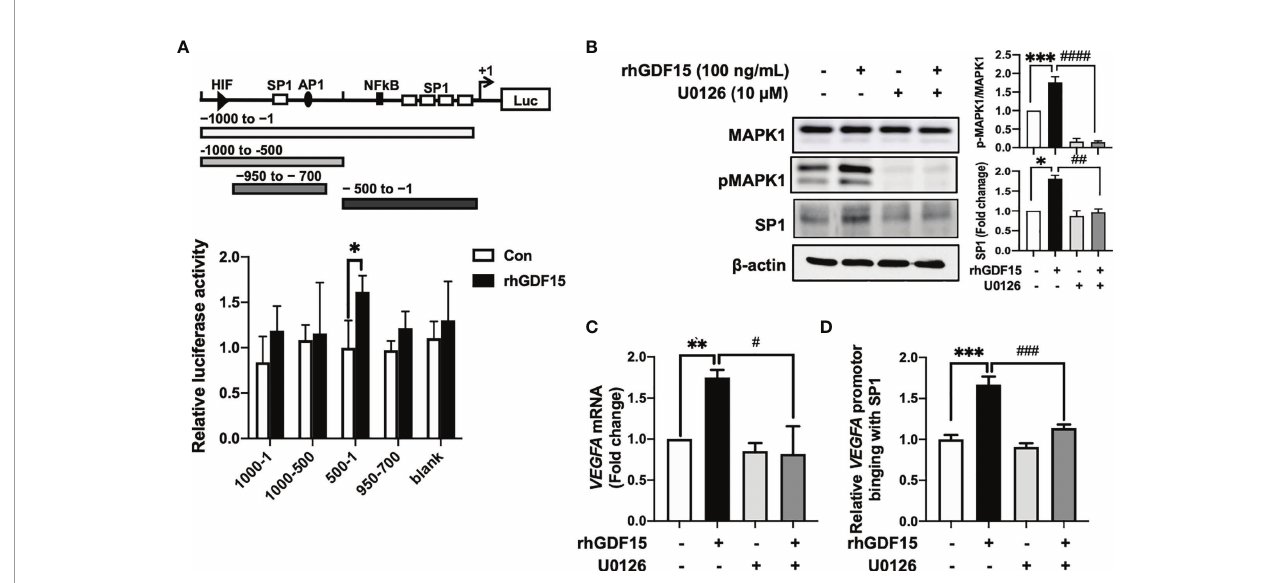
FIGURE 3 | GDF15 upregulates VEGFA transcription by promoting the binding of SP1 to its promoter. (A) 293T cells were transfected with a luciferase construct containing different VEGFA promotor regions or control vectors and treated with recombinant human GDF15 (rhGDF15). Data are presented as the mean ± standard deviation of three experiments (* p < 0.05). (B) For immunoblotting analysis of MAPK1, p-MAPK1, and SP1 in U373 cells, the cells were incubated for 1 h in the presence or absence of a MAPK1 inhibitor (U0126) and treated with rhGDF15 for 6 h. (C) Quantitative reverse transcription polymerase chain reaction (qRT-PCR) analysis of VEGFA mRNA expression in U373 cells treated with rhGDF15 and/or U0126. qRT-PCR analysis was performed using samples extracted 12 h post- rhGDF15 treatment. For inhibition studies, U373 cells were incubated with 10 µM U0126 for 1 h before treatment with 100 ng/mL rhGDF15. (D) Cells were incubated with or without rhGDF15 and U0126 and subjected to chromatin immunoprecipitation (ChIP) assay using anti-SP1 or IgG isotype control antibodies. Bar graphs represent the qRT-PCR results for immunoprecipitated VEGFA promoter. Data are presented as the mean ± standard error (** p < 0.01 and *** p < 0.001 compared with control group; # p < 0.05, ## p < 0.01, ### p < 0.001 and #### p < 0.0001 compared with rhGDF15-treated